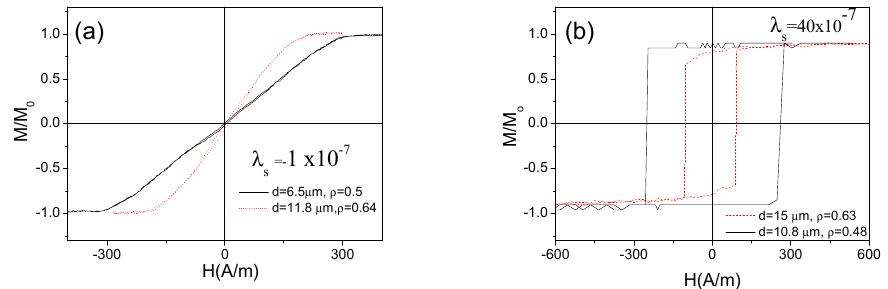
Figure 2. Hysteresis loops of as-prepared Co 67 Fe 3.85 Ni 1.45 B 11.5 Si 14.5 Mo 1.7 ( a ) and Fe 75 B 9 Si 12 C 4 ( b ) microwires with different ρ ratios.